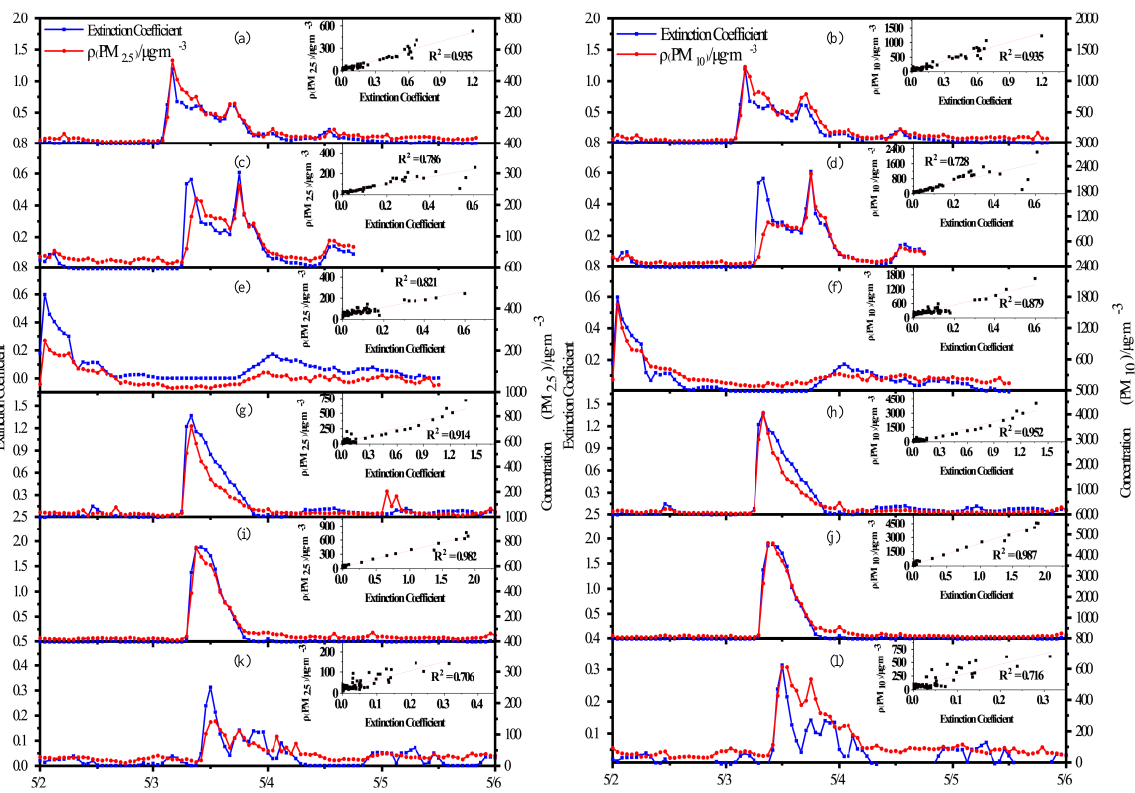
Figure 7. Relationship between extinction coefficient of 532 nm at 150 m and PM 2.5 , PM 10 concentration from ground observation in different cities (from top to bottom: Jiayuguan ( a ), ( b ), Yumen ( c ), ( d ), Aksay ( e ), ( f ), Jinchang ( g ), ( h ), Wuwei ( i ), ( j ), Baiyin ( k ), ( l )).